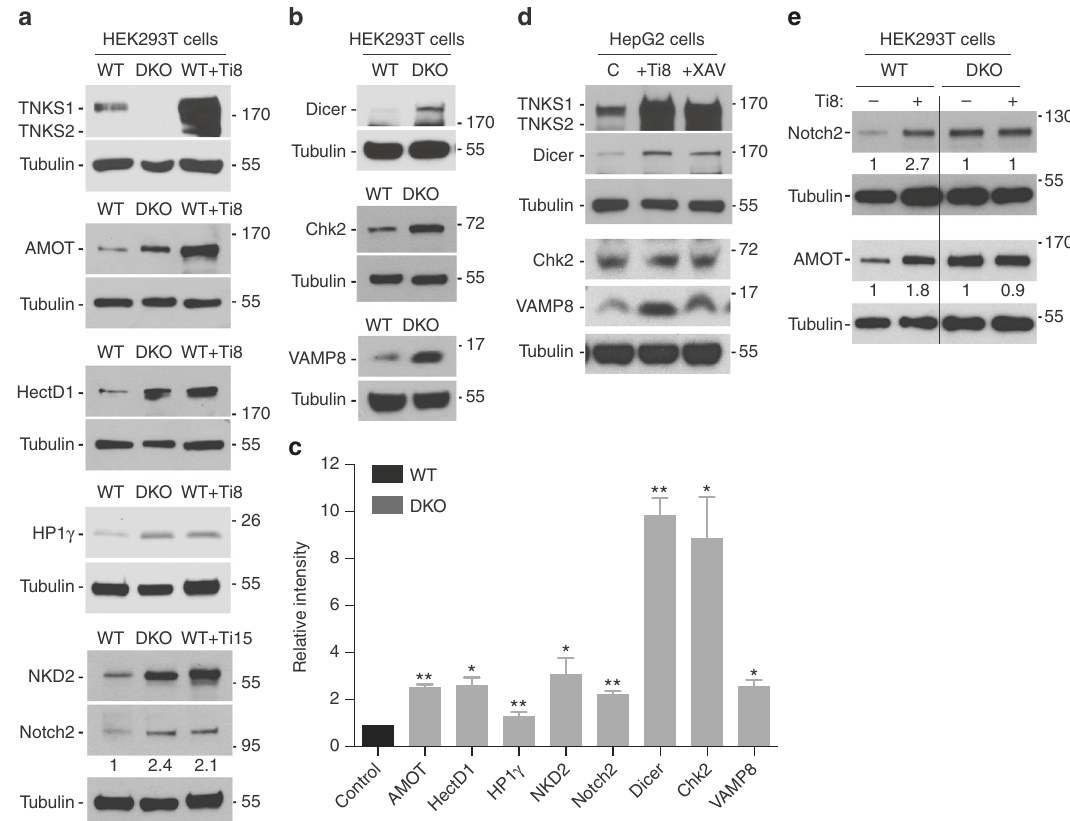
Fig. 3 Validation of candidates from the proteomic screen. a Immunoblot analysis of HEK293T WT, TNKS DKO, or WT plus tankyrase inhibitor (Ti8 or Ti15) with the indicated antibodies. Protein levels of Notch2 in DKO and WT + Ti15 relative to tubulin and normalized to WT cells are indicated below the blot. b Immunoblot analysis of HEK293T WT or TNKS DKO cells with the indicated antibodies. c Plot of the abundance of the indicated proteins in